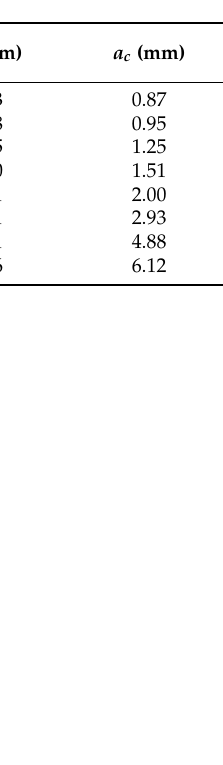
Table 5. Crack depth under different cyclic loads.